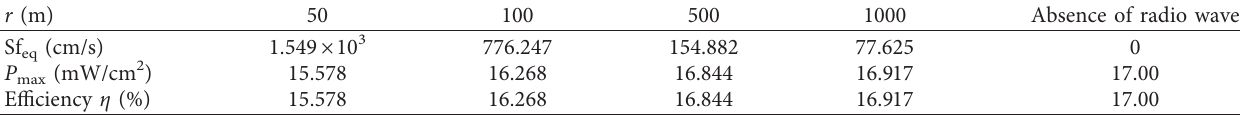
Table 3: Junction dynamic velocity at the equilibrium and efficiency for various